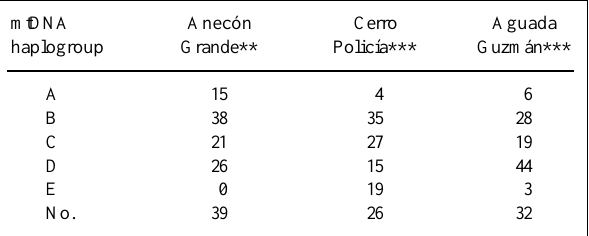
Table IV - mtDNA haplogroups (%) in the Indian populations studied.* mtDNA